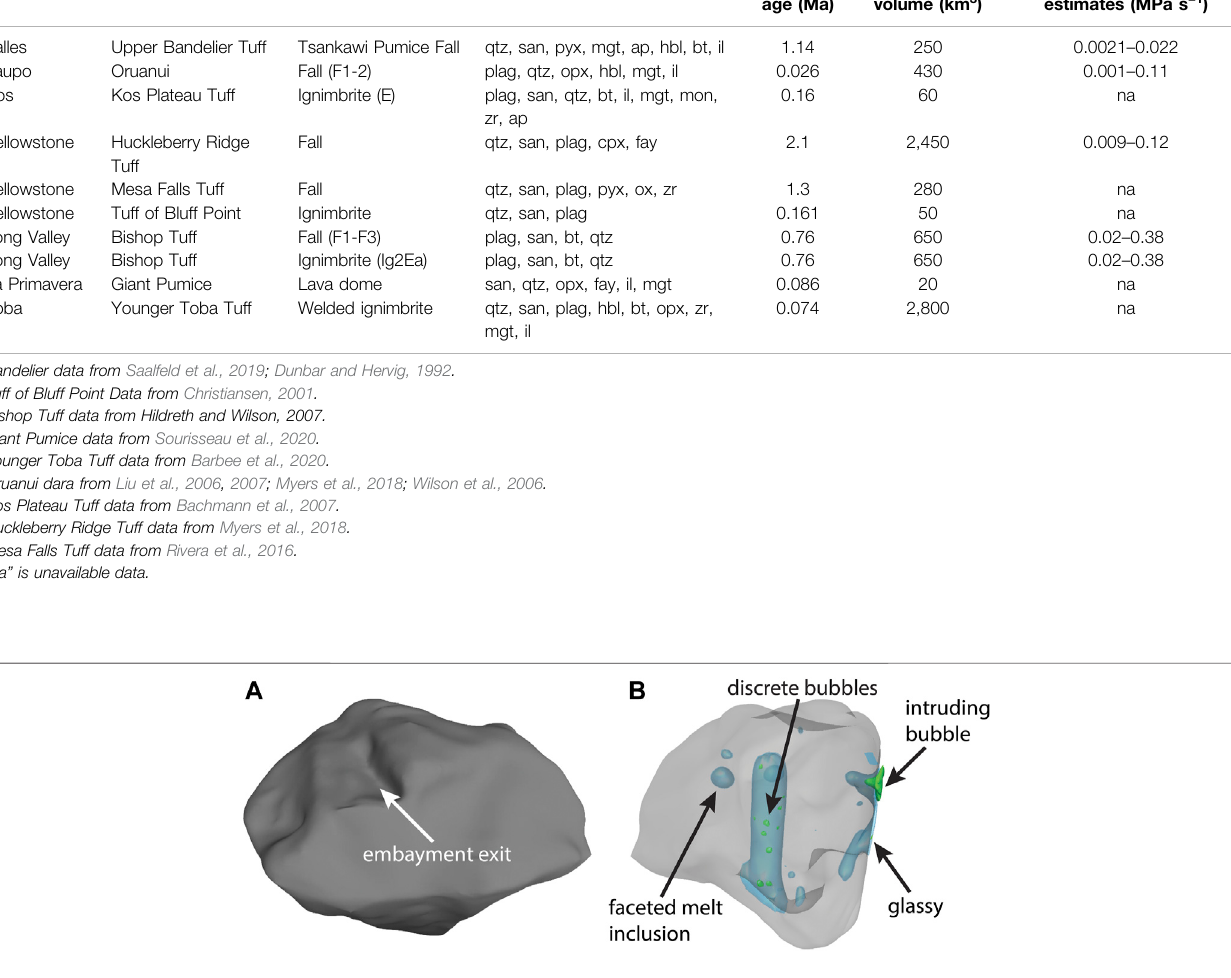
TABLE 1 | Summary of data. Volcano